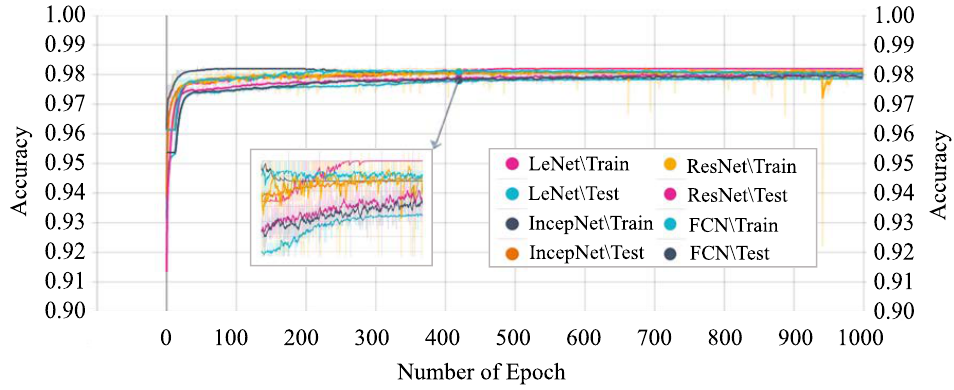
Figure 11. DTL models’ training and testing accuracy.